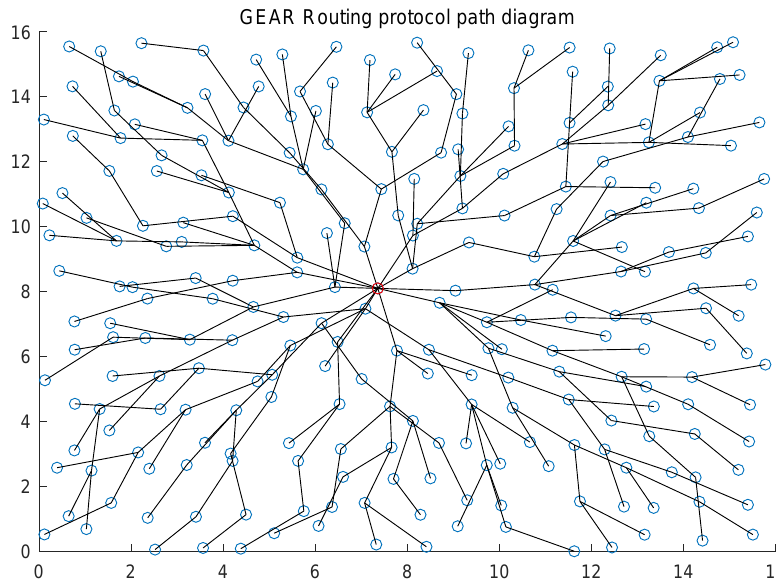
Figure 3. The figure shows the WSN topology corresponding to GEAR routing protocol without energy consumption factors taken into consideration. The red nod represents station. There are a total of 256 nodes within the network, the maximum communication distance of nodes is 2, and 1 node is randomly distributed within each 1 × 1 square box.